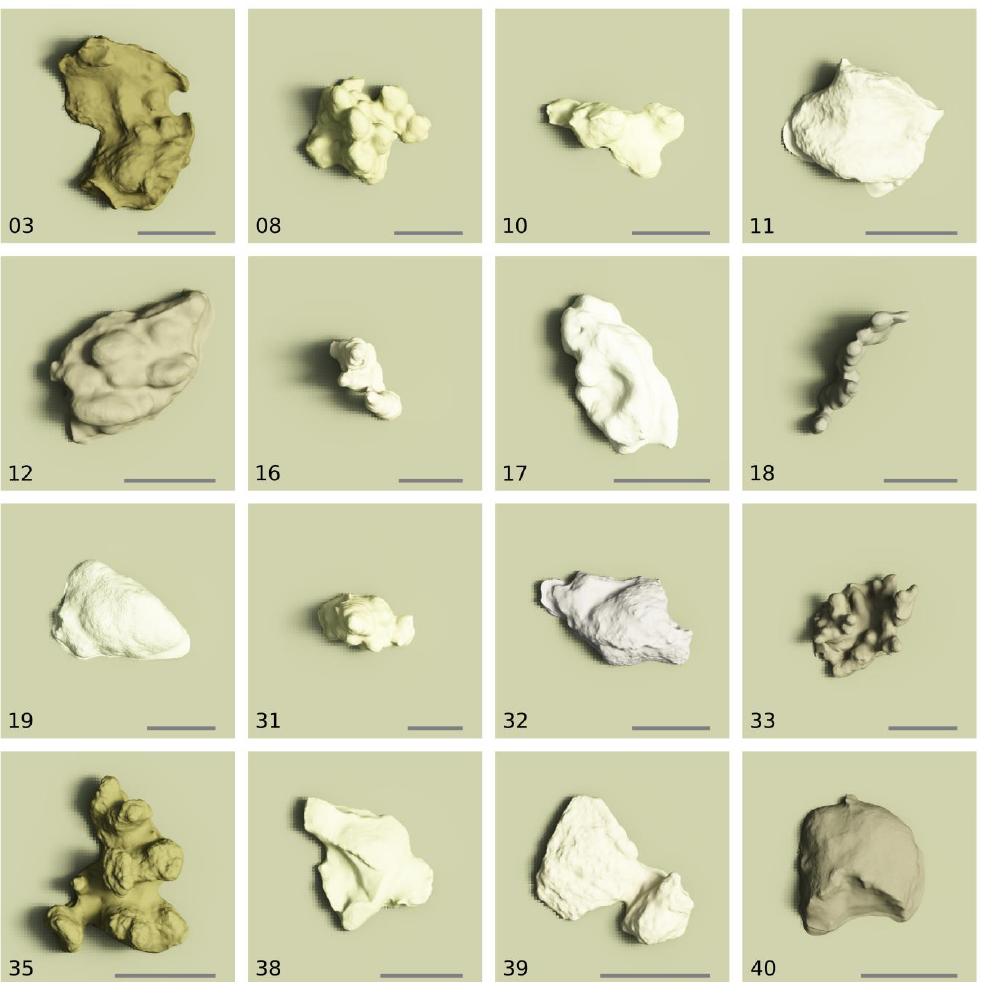
Figure 3. High resolution model outputs, as a nadir-view orthogonal projected rendering above each coral, converted to RGB using the tristimulus functions [24]. Illumination conditions are solar zenith θ s = 50 ◦ , forereef IOPs, depth 1 m. These are the high-resolution models without interstitial IOPs (activity 1, Table 1). Note: Corals are not shown in the same relative scale, bar is 5 cm.